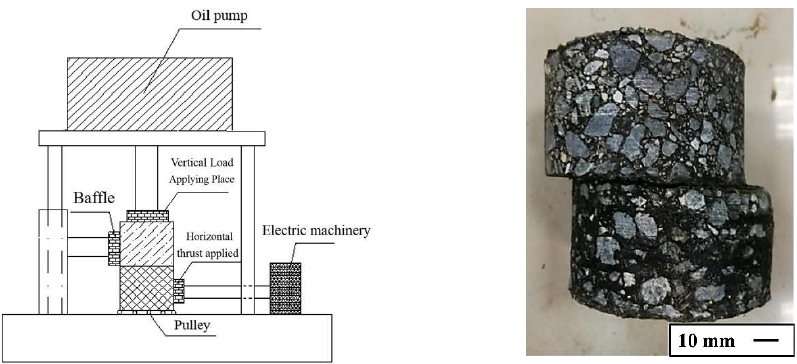
Figure 5. Schematic diagram of pavement interlayer material shear tester.